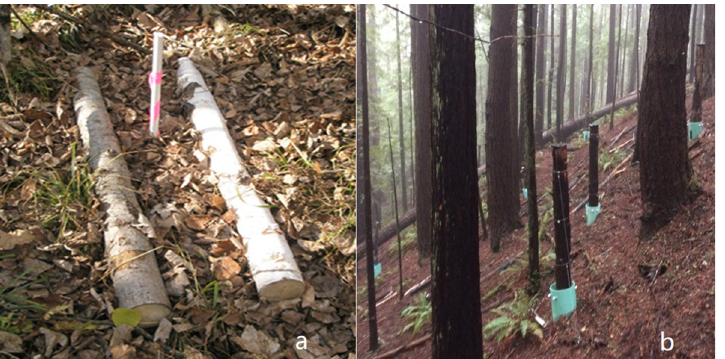
Fig 2. Horizontal (downed) FACE logs. (a) and vertical (standing) FACE woods